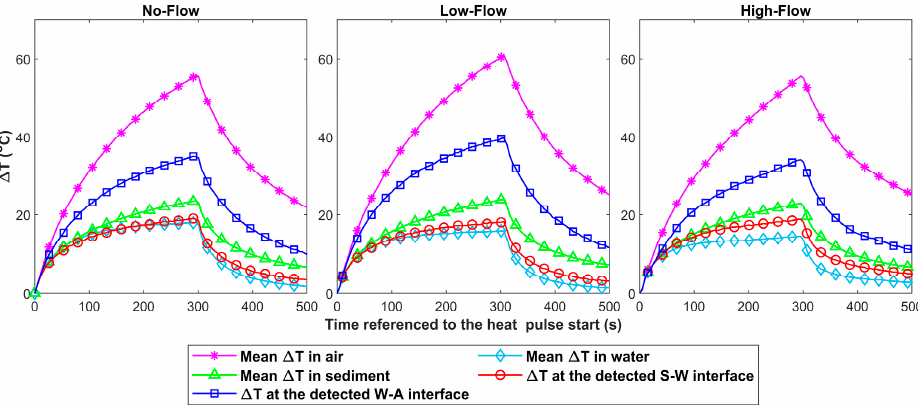
Figure 6. Examples of the ∆𝑇 observed during and after the application of the heat pulse at the detected S-W and W-A interfaces and the mean ∆𝑇 observed in the device sections surrounded by sediment, water, and air. The markers used to distinguish the di ff erent ∆𝑇 signals were added every fi ve measurements for clarity purposes.